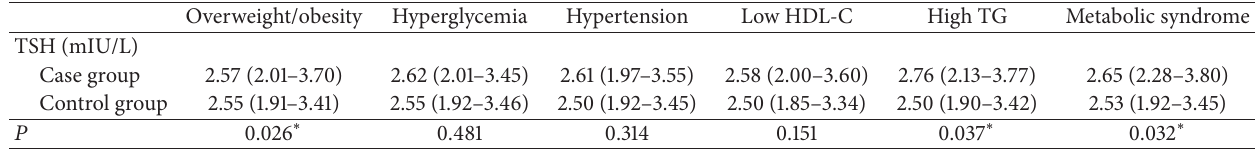
Table 3: Comparison of serum TSH levels in different components of metabolic syndrome between the case and control groups.